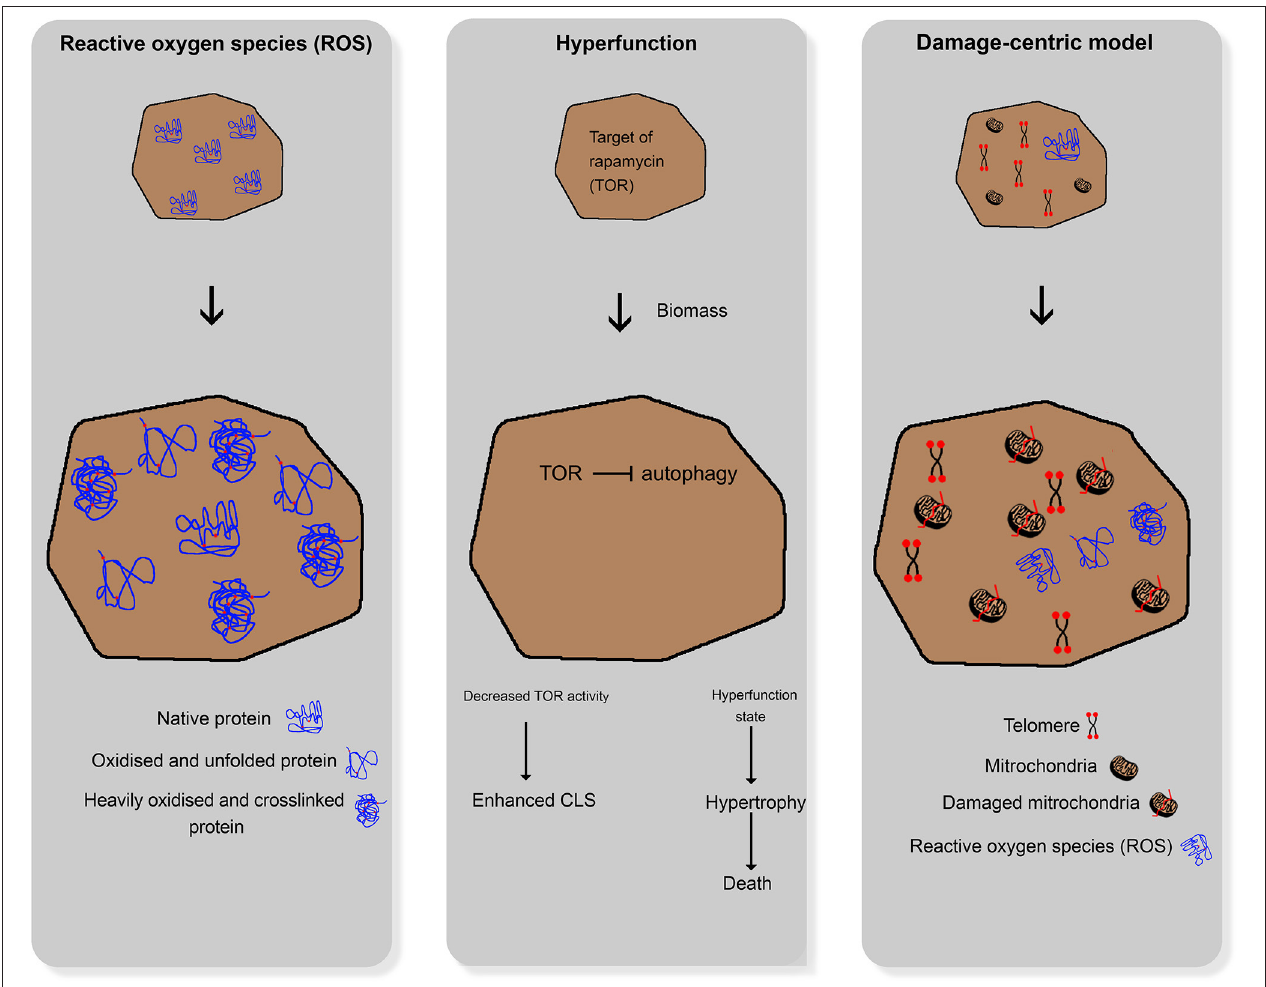
FIGURE 1 | Comparative illustration of the three main aging theories for higher organisms; left: reactive oxygen species damaging cellular structures; middle: hyperfunction theory; right: damage-centric